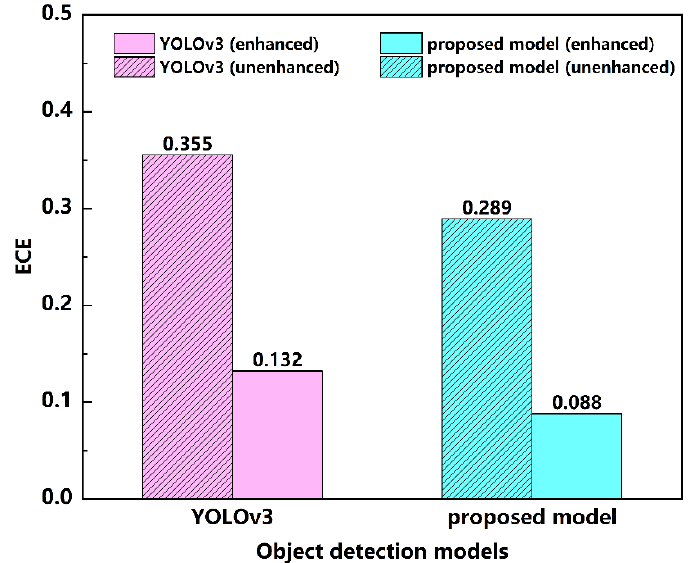
Figure 9. ECE indices of YOLOv3 model and proposed model before and after data augmentation.